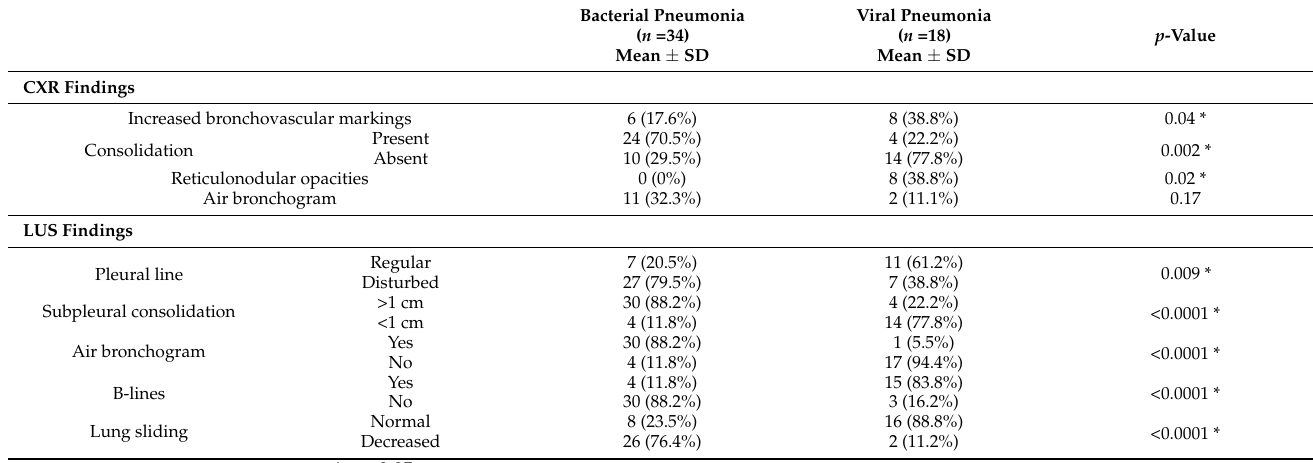
Table 2. CXR and LUS findings in both